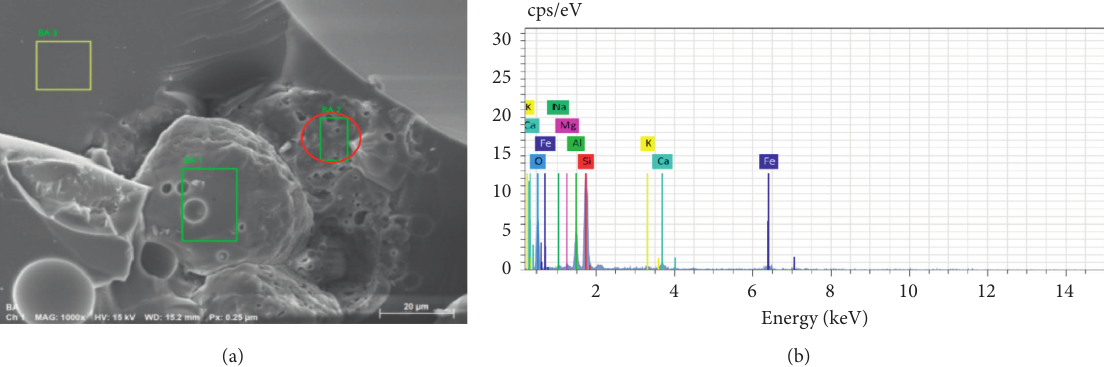
Figure 3: SEM and EDS results of the CBA. (a) SEM morphology of the CBA. (b) EDS spectra of the CBA (at the red circle in (a)). Table 3: Mixing proportions of the CBA concrete. Replacement of fine aggregates Mixture with CBA